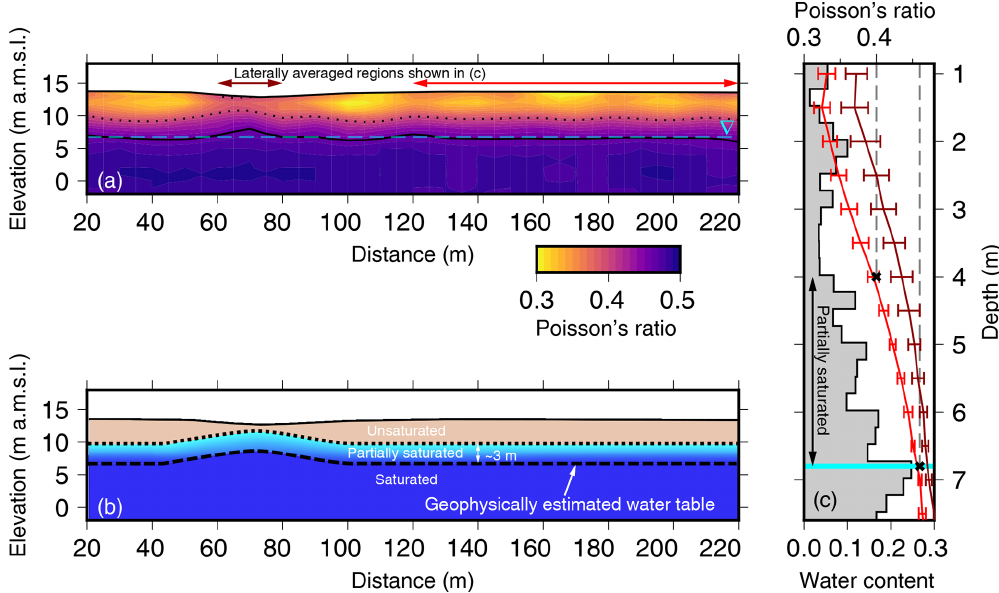
Figure 5. (a) Profile of Poisson’s ratio calculated using Eq. (1) and the profiles shown in Figs. 2 and 3. The solid black contour represents a Poisson’s ratio of 0.46. The dashed cyan line is the depth of water measured at the drill hole located at 220m (6.8mb.g.s. – below ground surface) and extends horizontally across the profile to be able to visualize the changes beneath the ephemeral feature. The dotted contour line is the 0.4 contour line, which is consistent with a 3m thick partially saturated region. (b) Geophysically interpreted hydrogeological cross section. The unsaturated zone is quantified by areas with Poisson’s ratios less than 0.40. The partially saturated region, with a thickness of approximately 3m (determined from NMR in c ), has Poisson’s ratios between 0.4 and 0.46. The fully saturated region has Poisson’s ratios greater than 0.46. The geophysically inferred water table is approximated by the 0.46 contour in (a) . (c) The water content profile from Fig. 4. The partially saturated region from 4 to 6.8m depth is highlighted. The horizontal cyan bar is the manual water level measurement (6.8m). Overlain on the water content profile are the two horizontally averaged 1D Poisson’s ratio profiles. The red line is averaged from 120 to 220m and the maroon line is averaged between 60 and 80m along the profile. Black dashed lines and solid crosses highlight the Poisson’s ratio contour values of 0.4 and 0.46 chosen in (a) .